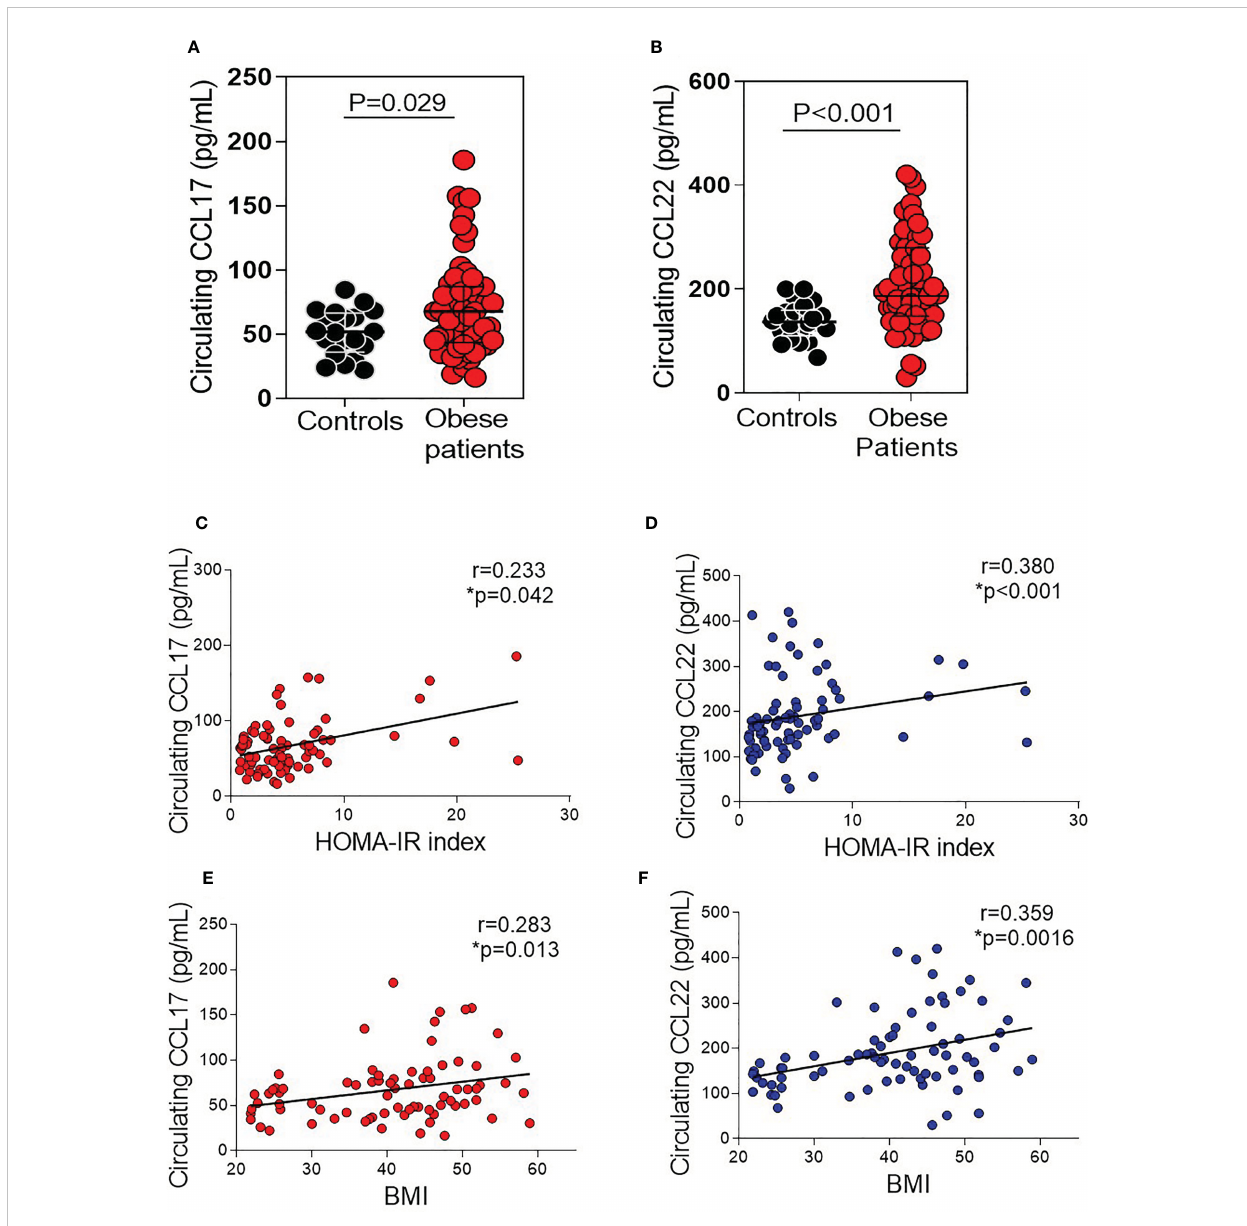
FIGURE 1 Circulating CCL17 and CCL22 chemokine levels in morbidly obese patients and age-matched controls. (A) CCL17 and (B) CCL22 levels were measured in plasma samples from obese patients (n = 60) and controls (n = 20). Scatter dot plots showing median with interquartile range. Comparison between groups were made by Mann Whitney test. Spearman test shows a positive correlation between CCL17 and CCL22 with HOMA- IR Index (C, D) and BMI (E, F) (n = 20 control subjects and n = 60 morbidly obese